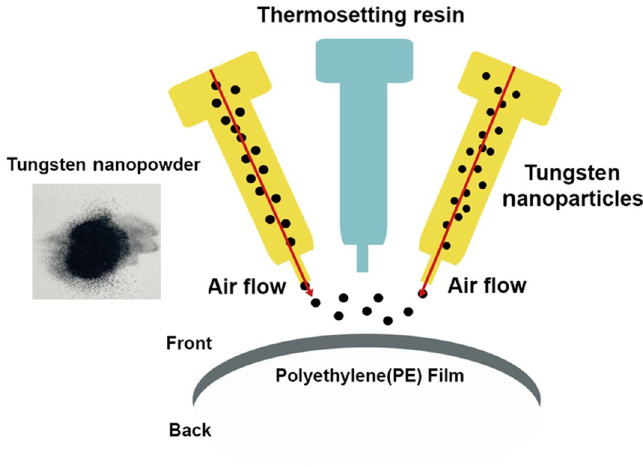
Figure 6. Fixing the dispersed particle on a PE